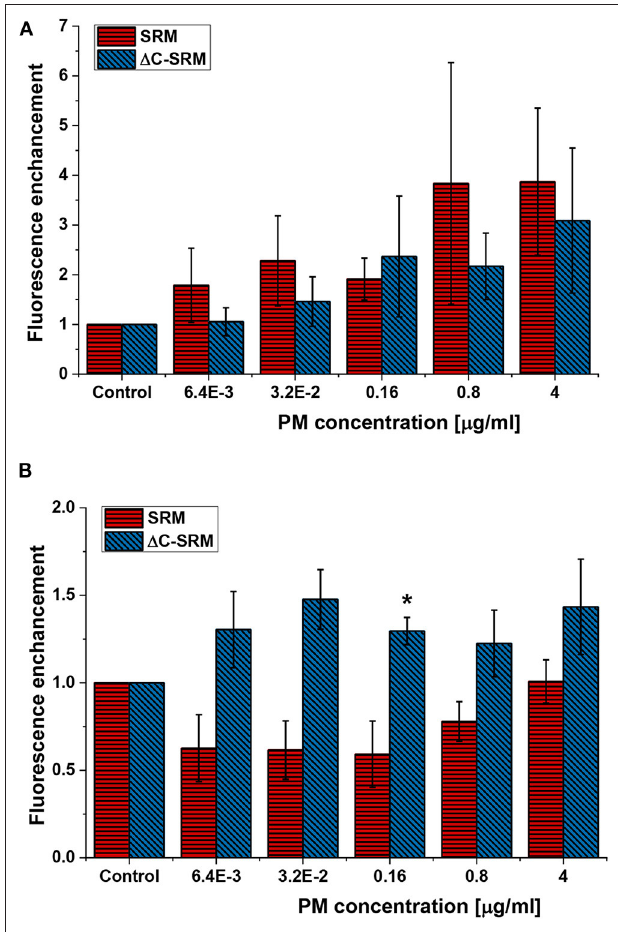
FIGURE 1 | The reactive oxygen species (ROS) production in A549 cells after their exposure to suspensions of SRM or 1 C-SRM for 24h (A) and 18 days (B) was evaluated using cyto-ID Hypoxia/Oxidative stress detection kit (exposure method 1), * p < 0.05.